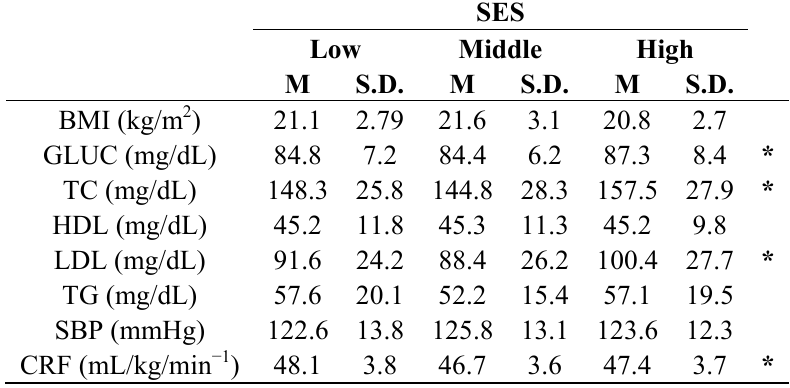
Table 1. Mean ± S.D. of individual components of the summed CVD risk score acoording to SES groups ( * inciates p = 0.05 or